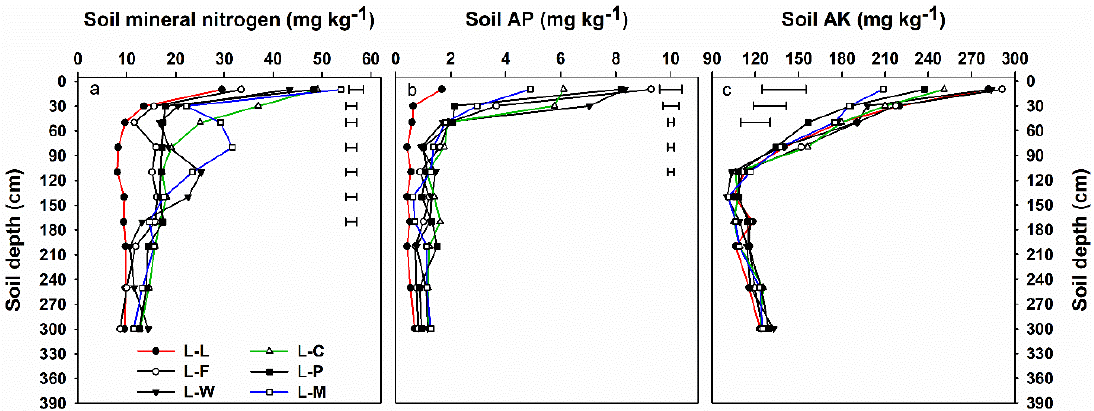
Figure 4. Soil mineral nitrogen ( a ), available phosphorus (AP) ( b ), and available potassium (AK) ( c ) after lucerne-to-crop conversion in October 2018. Horizontal bars denote Fisher’s protected least significant difference at p ≤ 0.05. Treatment abbreviations are defined in Table 1.